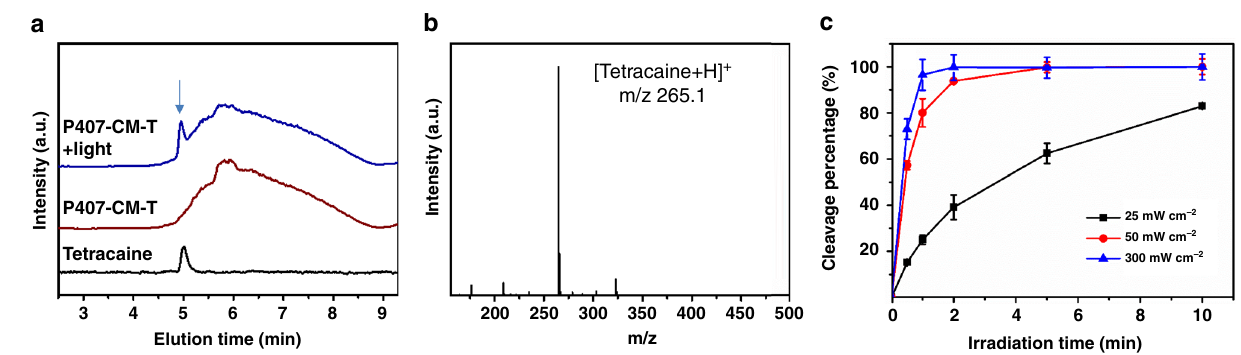
Fig. 3 In vitro photocleavage of P407-CM-T. a Liquid chromatography curves of tetracaine (black line), P407-CM-T before (brown line) and after cleavage (blue line) under 400nm LED irradiation. b Mass spectrum corresponding to the peak at 5 min in the curve of P407-CM-T + light in a . c Photocleavage of P407-CM-T solution (10 mg mL − 1 ) over time under 400 nm LED at different irradiances ( n = 4, Data are means ± SD) (black line: 25 mWcm − 2 ; red line: 50 mW cm − 2 ; blue line: 300 mW cm − 2 ). Source data are provided as a Source Data fi le.